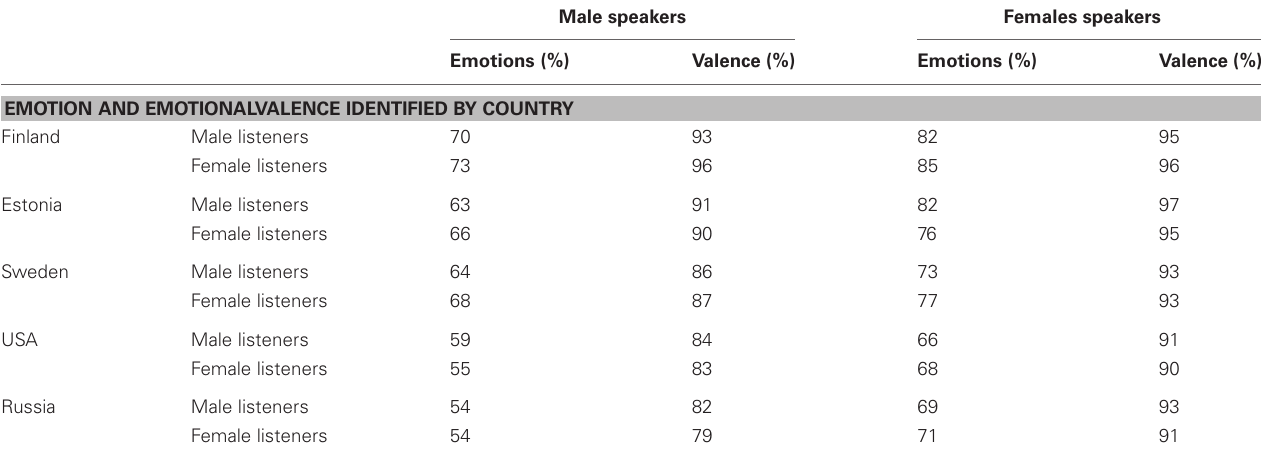
Table 8 | Accuracy of the identification of the emotions and valence in percentages when studied by country and gender. Male speakers Females speakers Emotions (%) Valence (%) Emotions (%) Valence (%) EMOTION AND EMOTIONALVALENCE IDENTIFIED BY COUNTRY